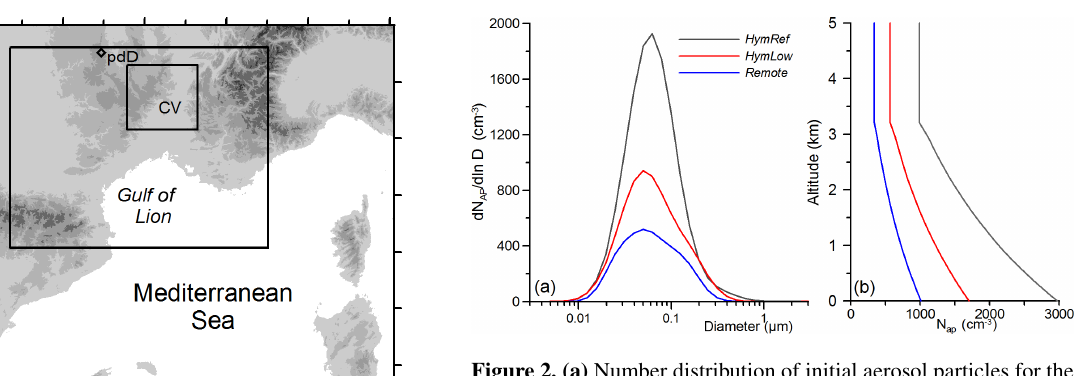
Figure 2. (a) Number distribution of initial aerosol particles for the three scenarios. (b) Initial vertical profiles of the total number of aerosol